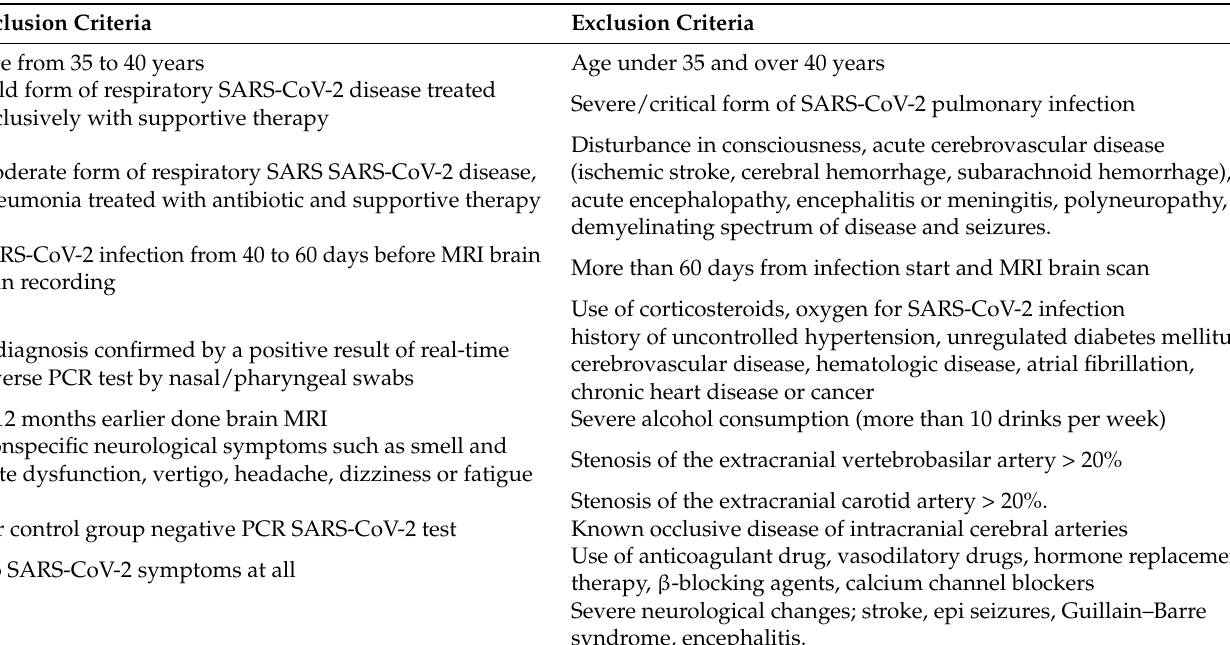
Table 1. Inclusion and exclusion